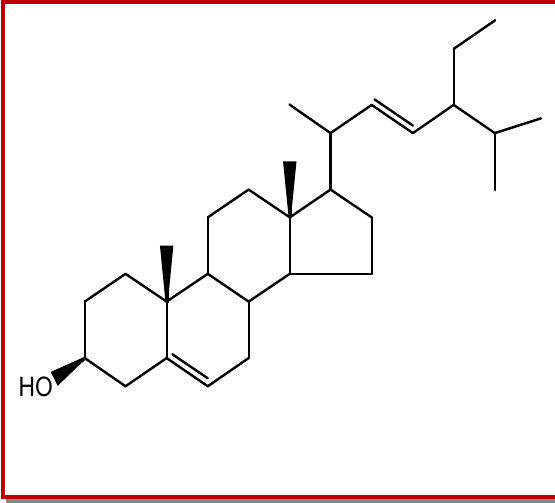
Figure 1: Chemical structure of lupeol (R = -H), betulinaldehyde (R = -